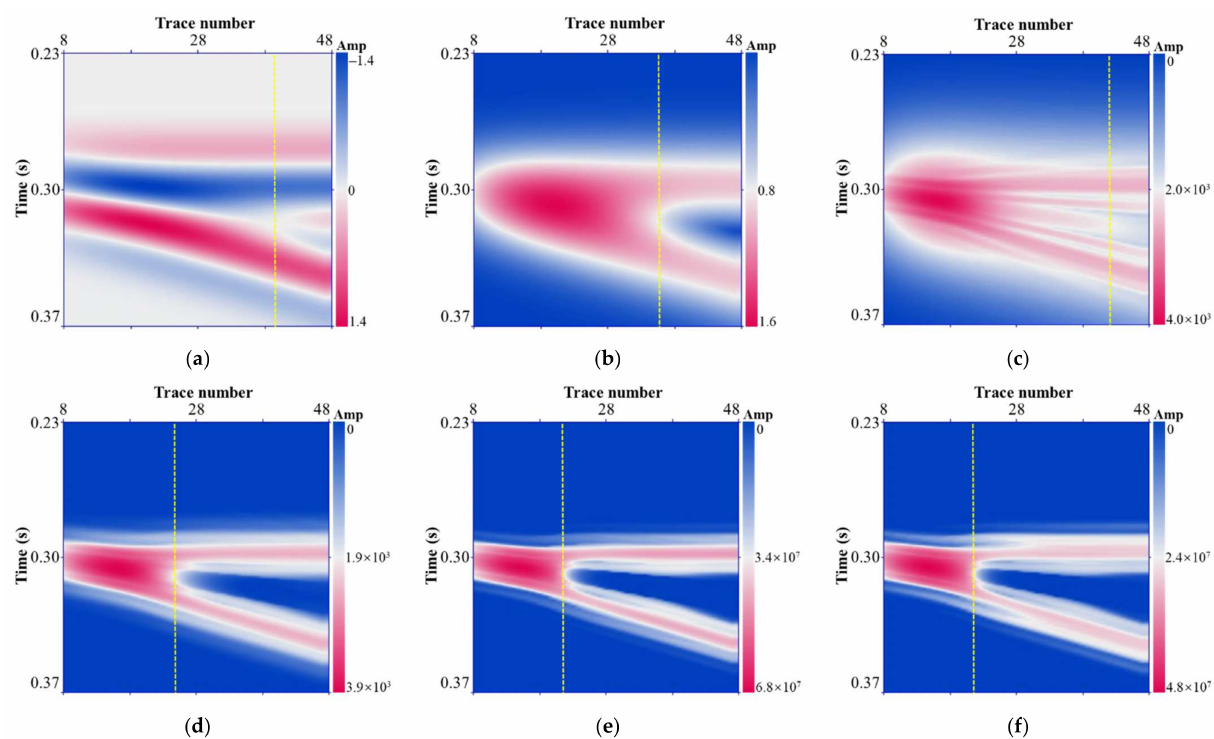
Figure 4. Zoomed-in views of yellow rectangles in Figure 3. ( a – f ) show the zoomed-in views of yellow rectangles in Figure 3a–f, respectively.